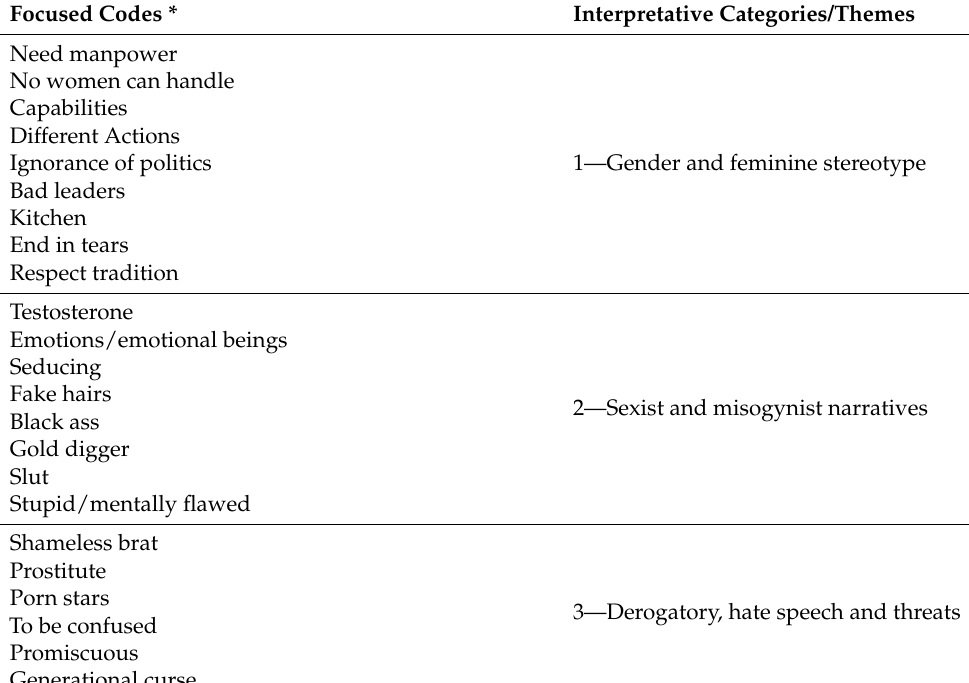
Table 4. Main focused codes and interpretative categories signifying sexualized gendered based